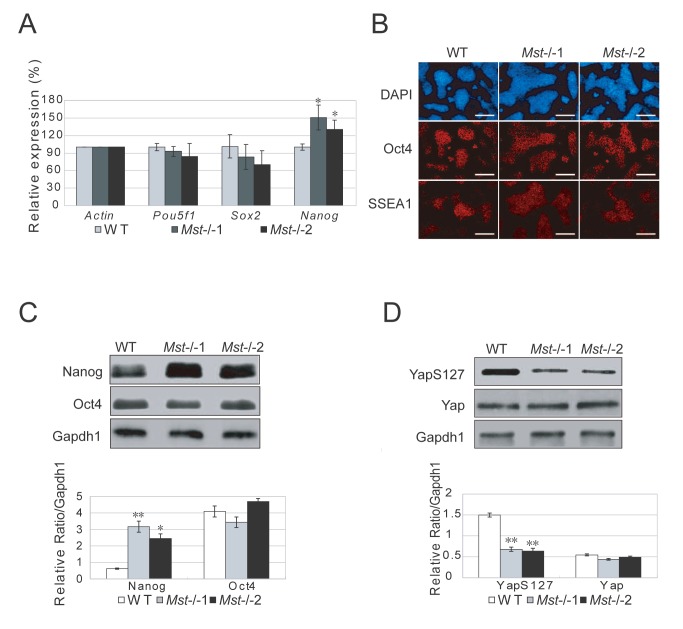
Characterization of Mst-/- ES cells.(A) Quantitative real-time PCR to examine the mRNA level of pluripotent markers Pou5f1, Sox2 and Nanog in wild type ES cells and Mst-/- knockout ES cells. Actin was analyzed as an internal control. The data are shown as the mean ± S.D (n=3). Statistically significant differences are indicated (*, P<0.05; **, P<0.01; ***, P<0.001). (B) Immunofluorescence staining of the pluripotent protein Oct4 and SSEA1 expression in wild type ES cells and Mst-/- knockout ES cells. Neuclei were stained with DAPI. Scale bar, 200μm. (C) Immunoblotting and densitometric analysis of Nanog and Oct4 in wild type ES cells and Mst-/- ES cells. Gapdh1 was analyzed as an internal control. The data are shown as the mean ± S.D (n=2). Statistically significant differences are indicated (*, P<0.05; **, P<0.01; ***, P<0.001). (D) Immunoblotting and densitometric analysis of the expression of Yap and phosphorylated Yap (YapS127) in wild type ES cells and Mst-/- ES cells. Gapdh1 was analyzed as an internal control. The data are shown as the mean ± S.D (n=2). Statistically significant differences are indicated (*, P<0.05; **, P<0.01; ***, P<0.001).